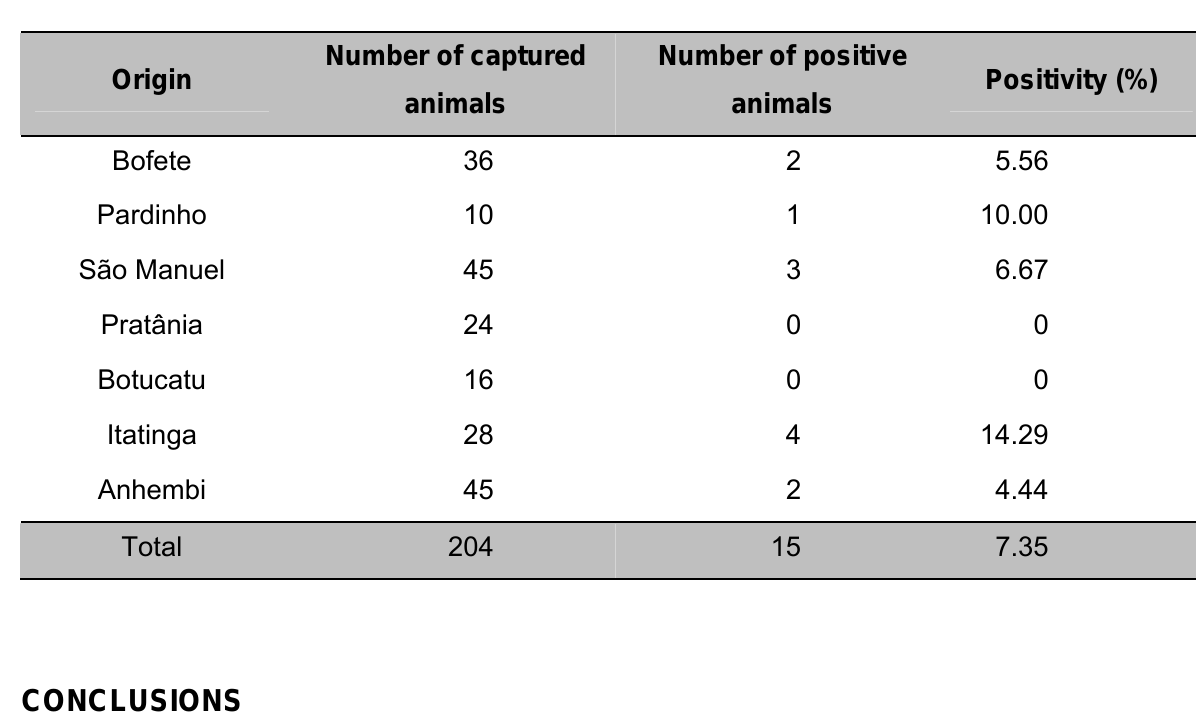
Table 1. Numbers and percentages of D. rotundus bats infected by rabies (RFFIT serology), in Botucatu region,